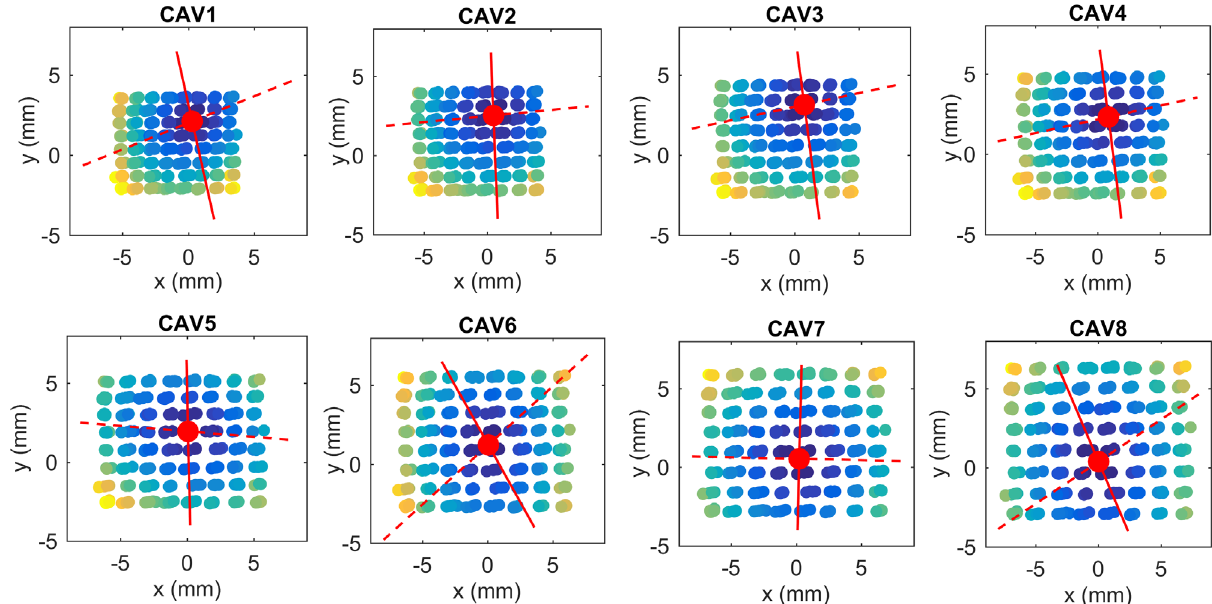
FIG. 20. Dipole mode polarization axes and centers for all eight cavities in ACC5. The dots are color coded by the normalized signal strength, giving a bright yellow point at one and a dark blue point at zero. For each cavity, the red solid line indicates the vertical axis ( ˜ y -axis) for polarization two and the red dash line indicates the horizontal axis ( ˜ x -axis) for polarization one. The red point of the intersection of the axes defines the electrical center of the dipole mode.